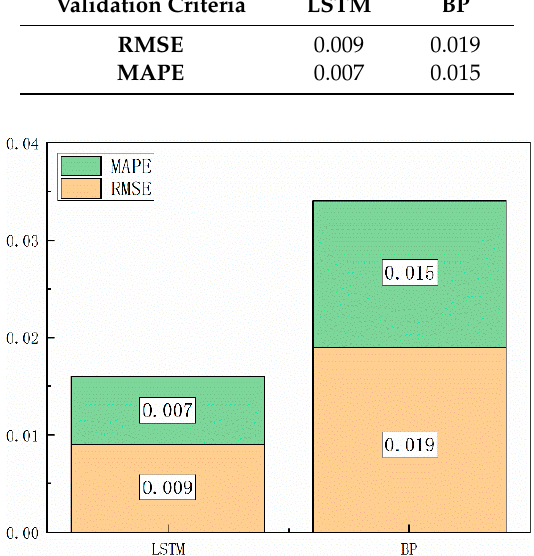
Figure 10. Error figure of the two methods.